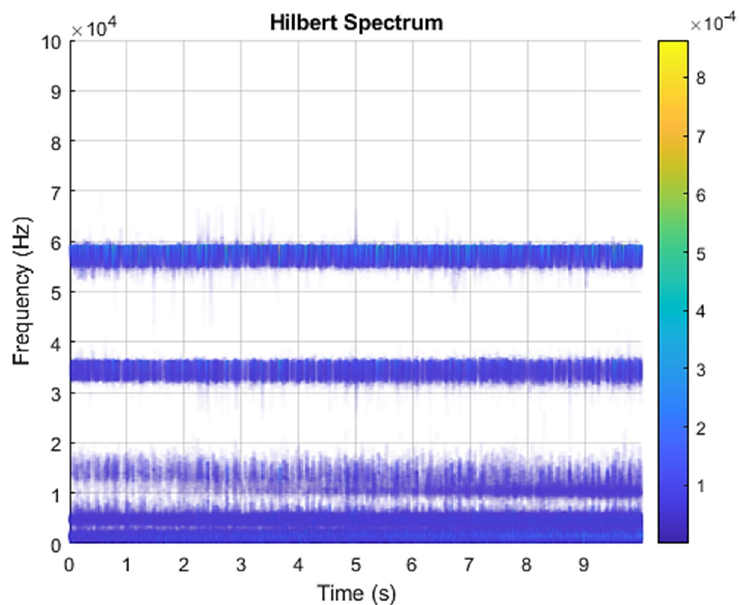
Figure 4. VMD analysis from a healthy bearing under increasing rotational speed condition in Hilbert spectrum.